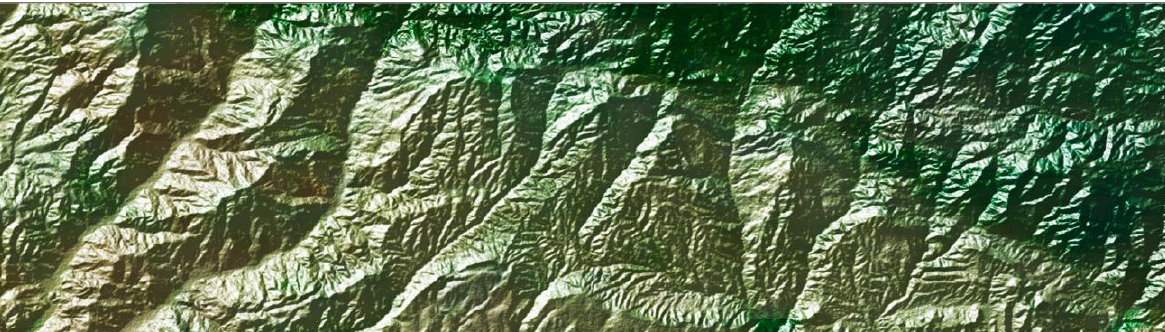
Figure 9. The combination of MODIS image with SRTM-1. Full resolution reduced 2x to show greater area (scale 1:400 000